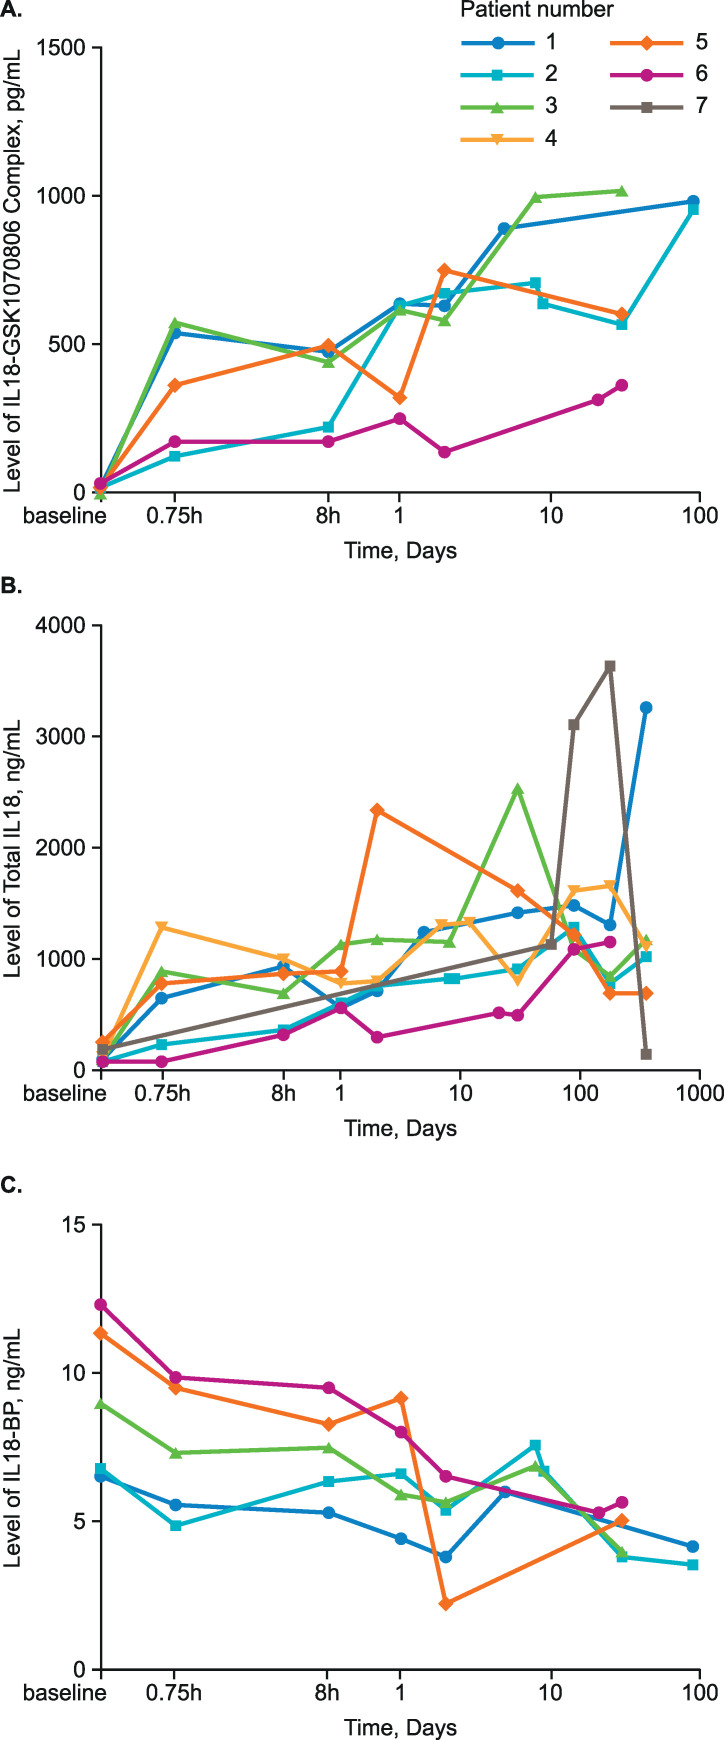
Serum levels of (A) IL18-GSK1070806 complex, (B) total IL18, and (C) IL18-BP over the study course. BP, binding protein; IL18, interleukin-18. Figures produced post hoc.